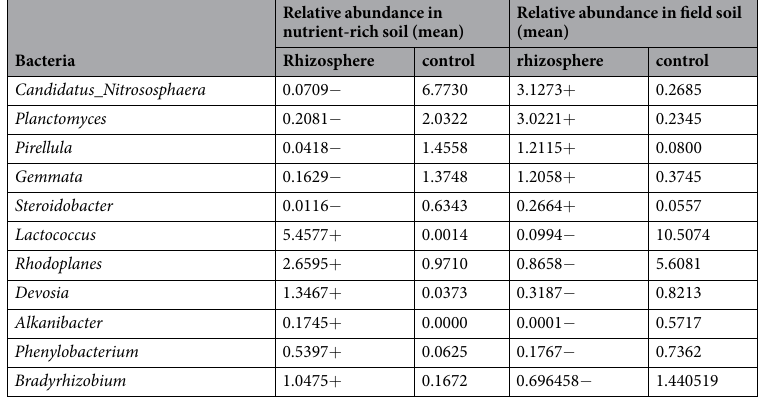
Table 1. Bacteria that effected opposite by cotton root in two soil types (“ − ” denotes bacteria that were less abundant in pots containing cotton plants, “ + ” denotes bacteria that were more abundant in pots containing cotton plants).